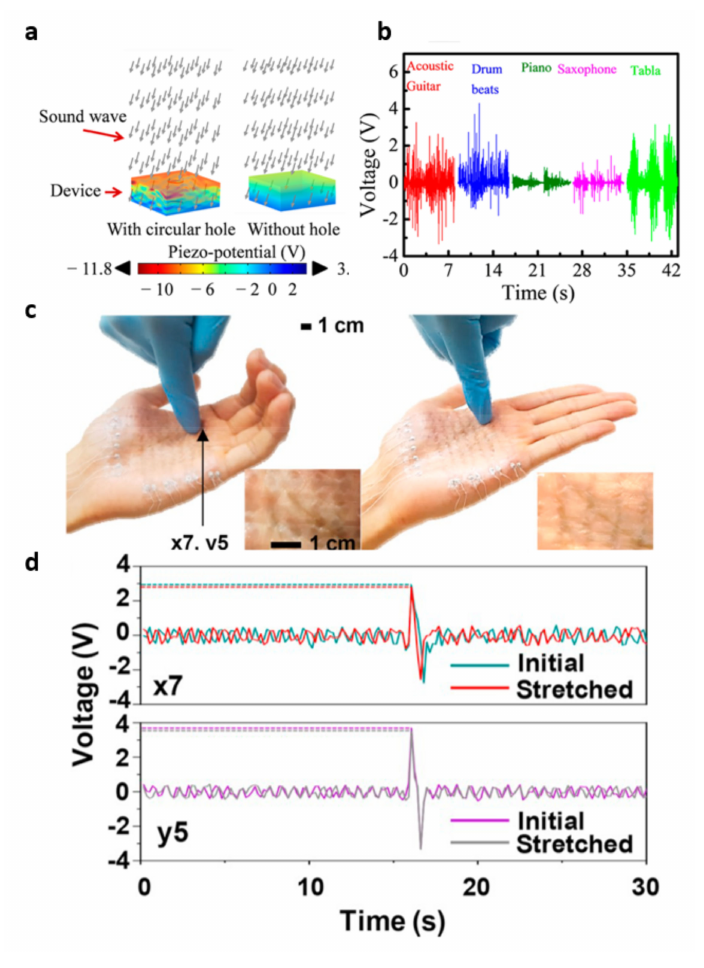
Figure 15. Self-powered sensor integrations: ( a ) a piezo-potential distribution analysis of acoustoelec- tric conversion and ( b ) output voltage characteristics conducted with different musical instruments under that sound pressure level. Reproduced with permission from [79], Copyright 2021, Ameri- can Chemical Society. ( c ) TENG touch sensor integration on the palm of the hand, and ( d ) output voltage measurement before and after stretching. Reproduced with permission from [80], Copyright 2019,